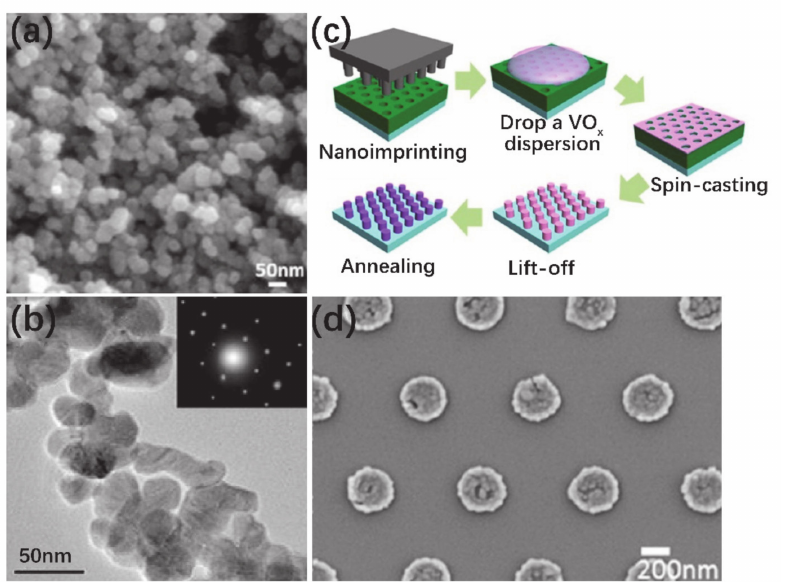
Figure 15. ( a ) SEM image of VO 2 nanopowders and ( b ) TEM image of VO 2 nanopowders; the inset is the SAED pattern of an individual particle. Reproduced from [106], with permission from Elsevier, 2011. ( c ) Schematic diagram of VO 2 nanostructure fabricated by nanoimprint lithography. ( d ) SEM image of VO 2 nanostructure arrays. Reproduced from [107], with permission from American Chemical Society,